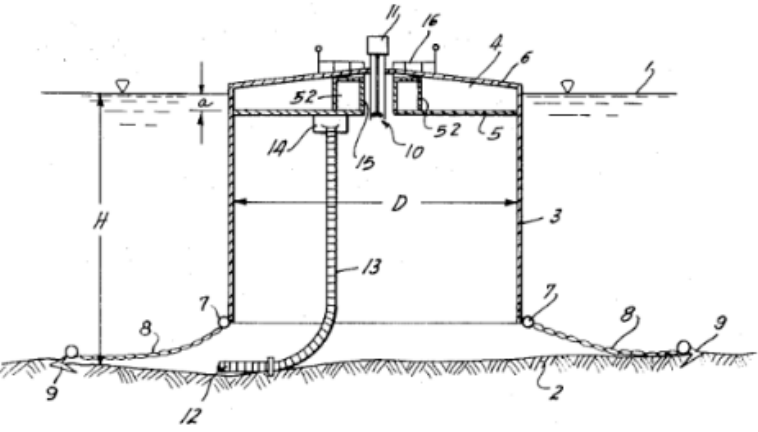
Figure 3. Floating Oil Storage Installation involving floating tank moored to fixed anchors [4].